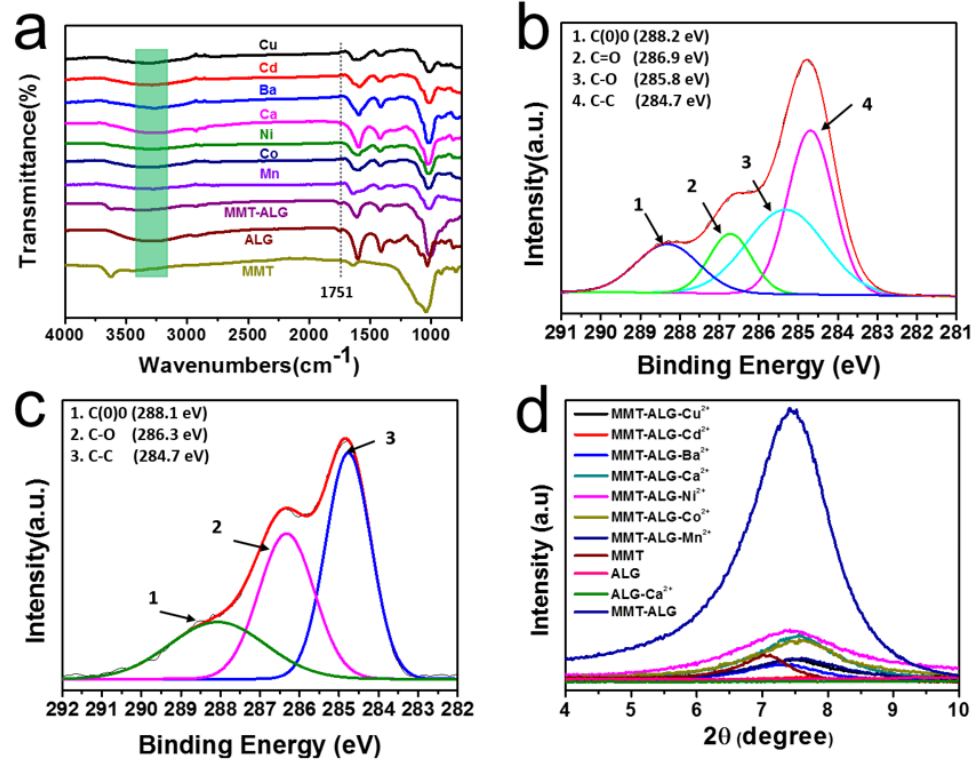
Figure 3. ( a ) FTIR spectra of MMT, ALG, MMT-ALG, MMT-ALG-X 2+ nanocomposites; ( b , c ) XPS spectra of C 1s for MMT-ALG ( b ) and MMT-ALG-Co 2+ ( c ) nanocomposites; ( d ) XRD patterns of MMT, ALG, MMT-ALG, MMT-ALG-X 2+